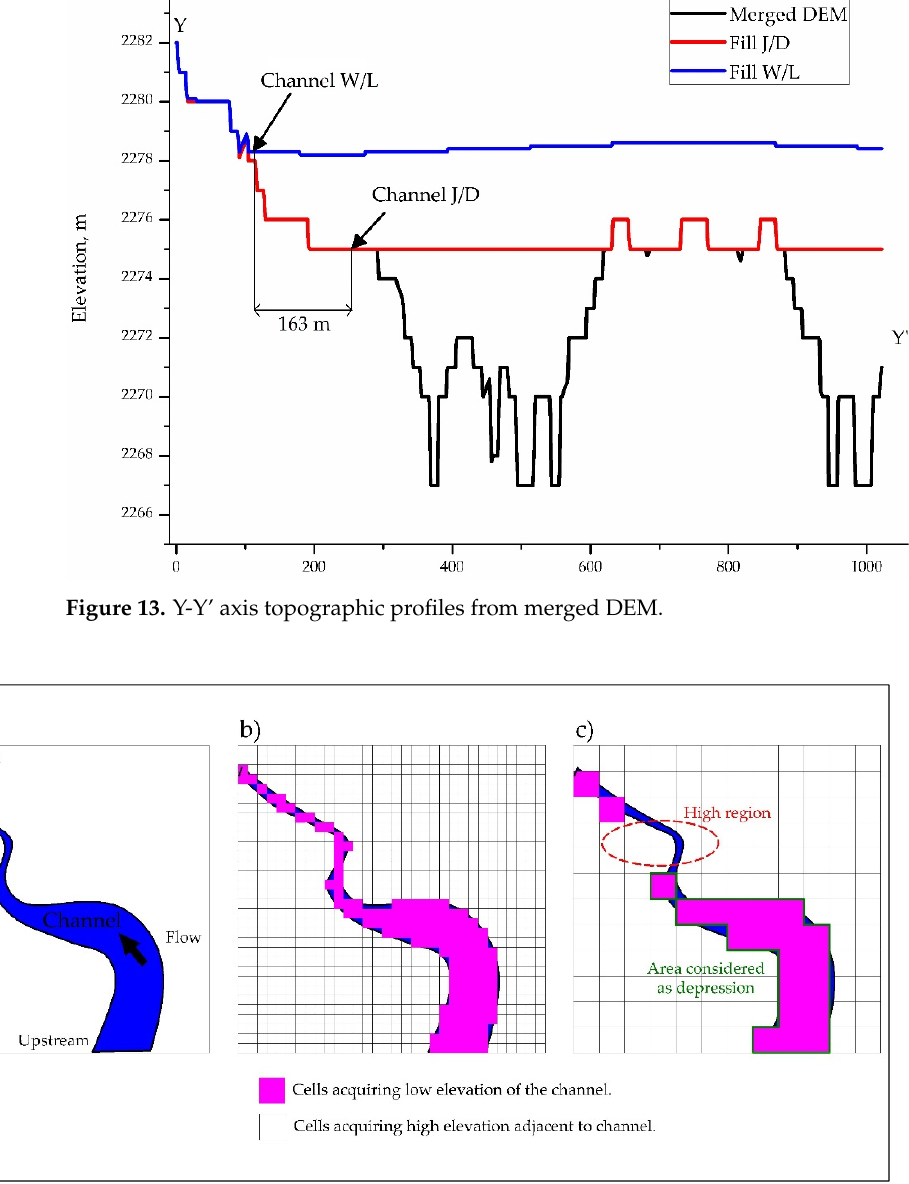
Figure 14. Allocation of elevations on DEMs and depression identification: ( a ) planar view of a hypothetical channel; ( b ) high-resolution DEM; and ( c ) low-resolution DEM.